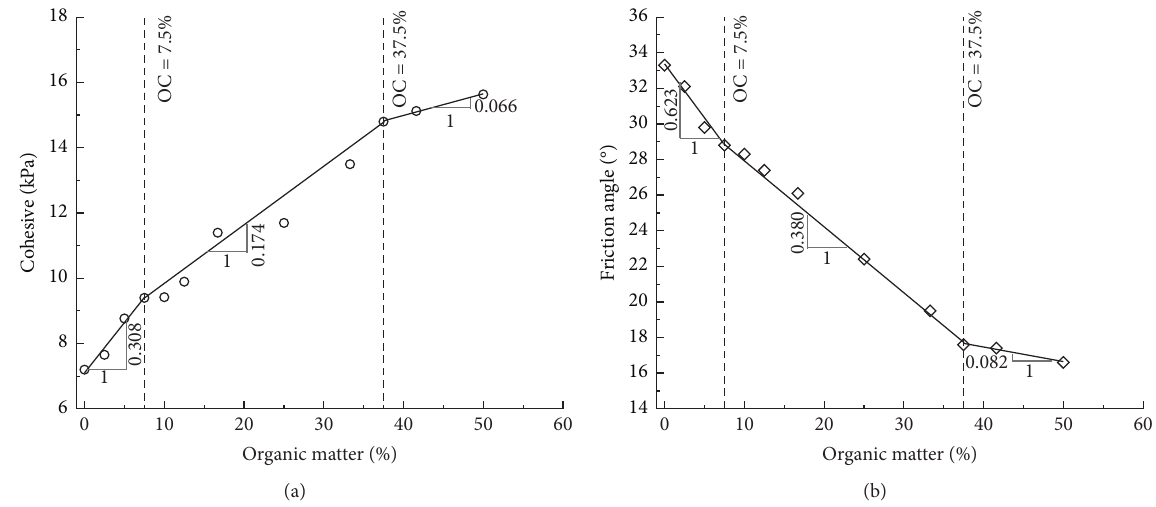
Figure 10: Relationship between organic matter content and cohesion and friction angle. (a) Cohesion. (b) Friction angle.